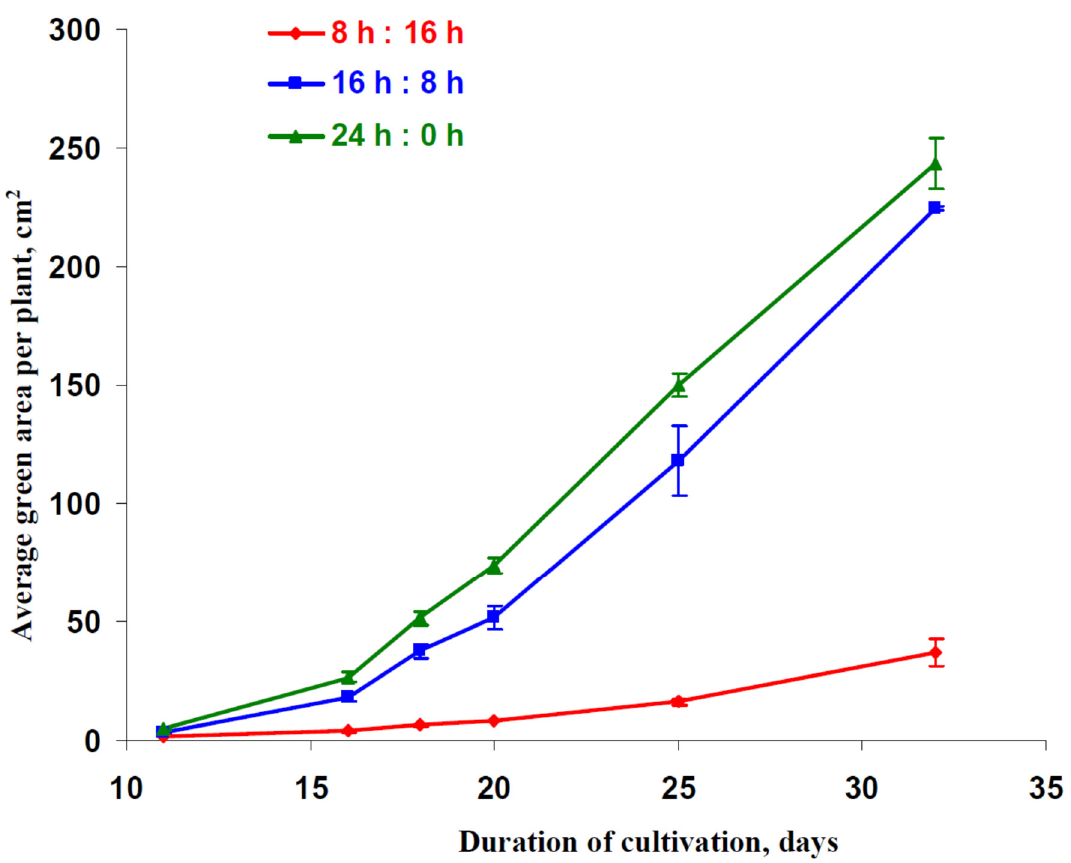
Figure 1. Time dependences of average green area per plant for lettuce cultivated under different photoperiods. “8 h:16 h” is 8 h (light):16 h (dark), “16 h:8 h” is 16 h (light):8 h (dark), and “24 h:0 h” is 24 h (light):0 h (dark). The green area was measured on the basis of a photo of lettuce